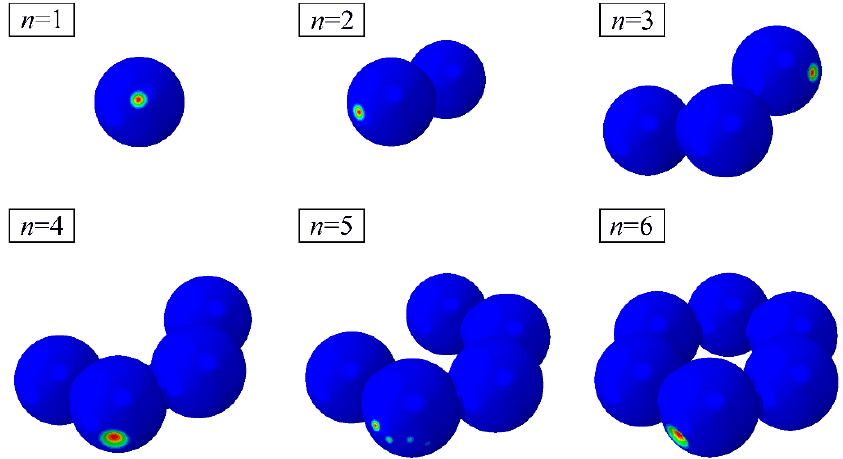
Figure 17. Post-buckling modes of sphere-segmented toroidal shells ( n = 1–6) correspond to Figure 16.